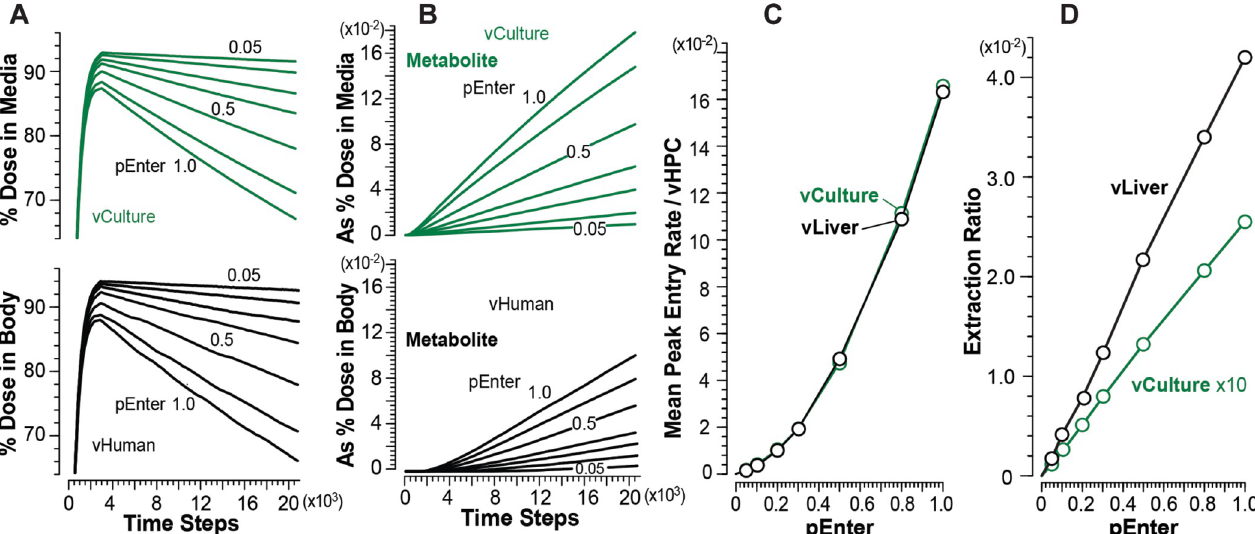
Fig 8. Results from vCulture and vHuman experiments using vC3. (A) Temporal measures of percent Dose in Body (top) and Media (bottom) for each pEnter . (B) Amount of Metabolite in Body (top) and Media (bottom) as percent of Dose for each pEnter . (C) Correlations between mean peak Entry rates and pEnter . (D) Correlations between mean Extraction Ratios and pEnter